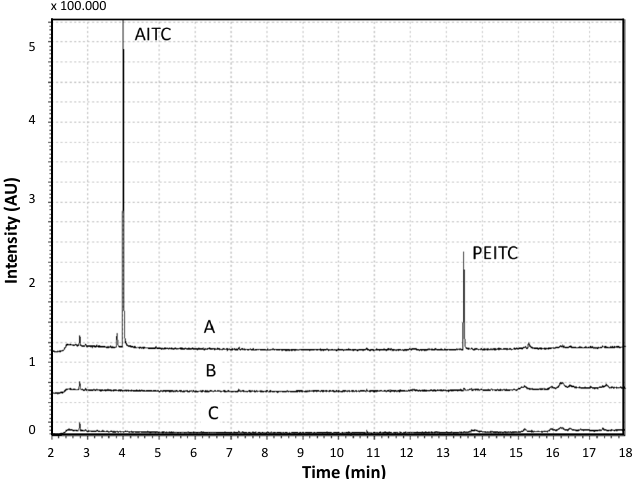
Fig. 2: GC-MS analysis of horseradish extracts prepared with different extracting agents. A – Aqueous extract; B – 4% Phosphoric acid extract; C – 4% Phosphoric acid extract after neutralization. AITC – allyl isothiocyanate; PEITC – phenethyl